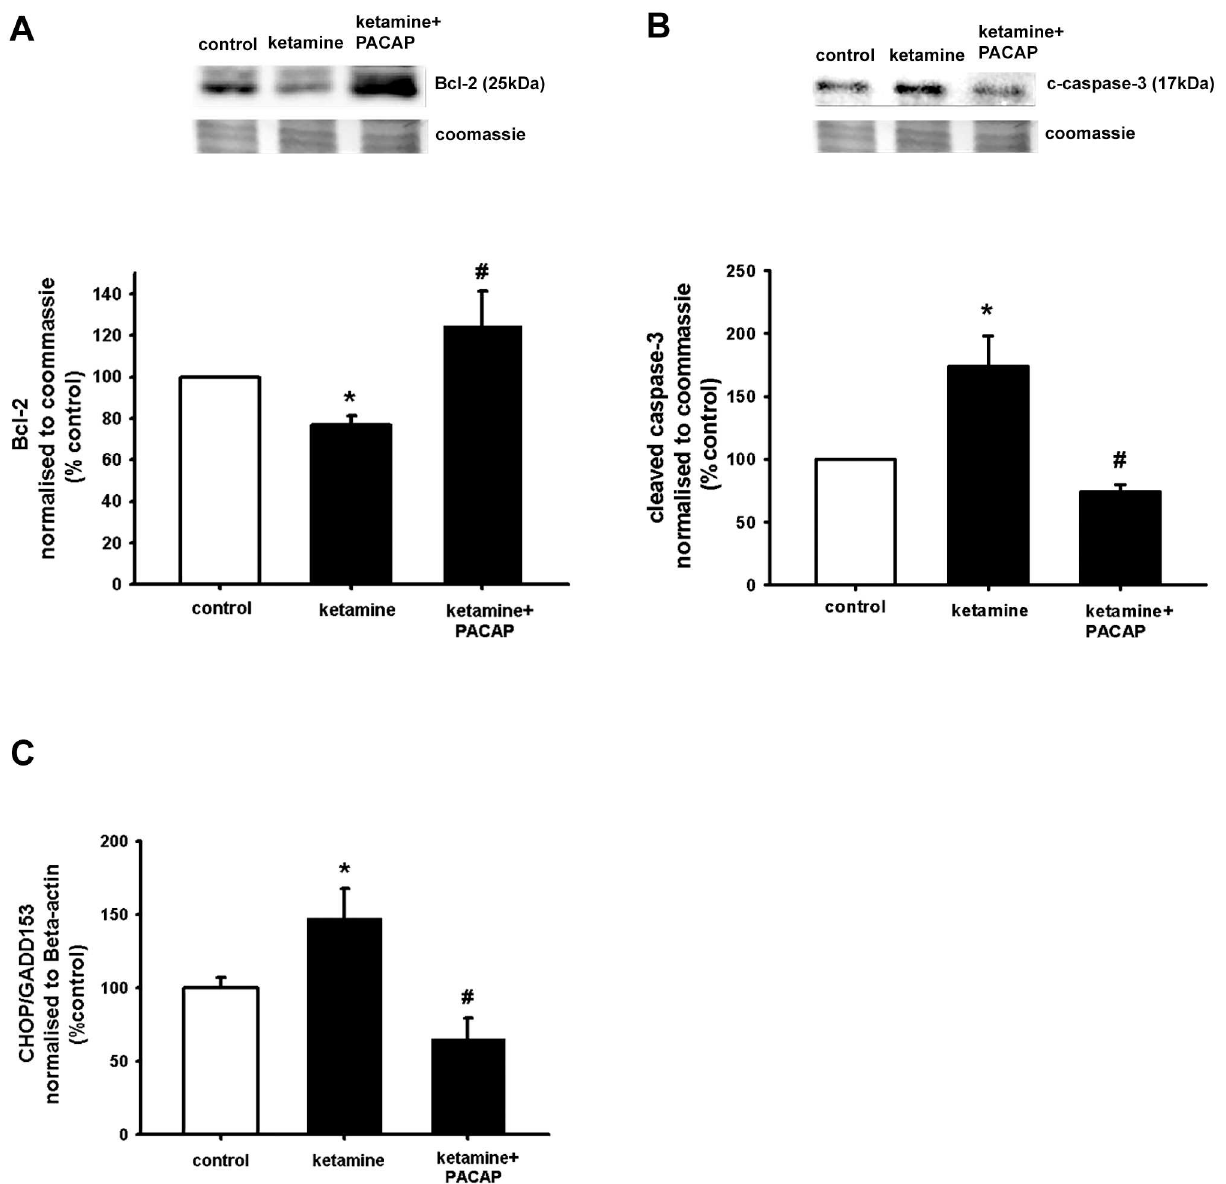
Fig 4. PACAP counteracts ketamine induced apoptosis and ER stress. NSCs were plated as single cells and treated with 400 μ M ketaminealone or with 100 nM PACAP and 400 μ M ketamine. After 24 hours incubation, cells were harvestedfor Western blot analysis (A, B) or harvestedfor mRNA extraction and quantitative RT-PCR experiments (C) . To obtainquantitative measurements Bcl-2 protein levels and cleaved caspase-3 were normalized against coomassie blue. Data are shown as mean ± SEM (A, n = 5–6; B, n = 3–5, C, n = 4–6). Kruskal- Wallis followedby Dunn’stest. Differenceswere considered significantat P < 0.05. * denotesP < 0.05 comparedwith control, # denotes P < 0.05 comparedto 400 μ M